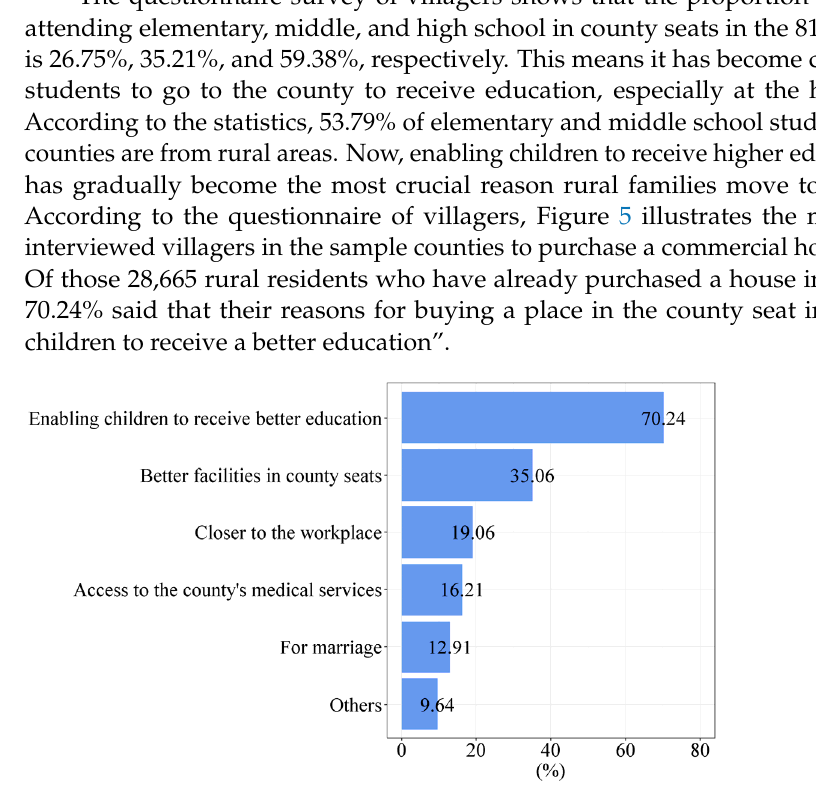
Figure 6. Rural residents’ choice of location for medical and health care (Source: by the authors). Therefore, with the increasing demand of rural residents for education and medical service levels of county seats, increasing the allocation of education and medical service resources and improving their quality is essential to promote the construction of urbani- zation with the county seat as the carrier. However, the level of education and medical services in the county seat has not yet met the needs of rural residents, and there are still apparent shortcomings. In terms of education services, according to statistics, the percentage of candidates admitted to Project 985 and Project 211 universities in the 81 sample counties in 2020 is only 3.84%, which is lower than the average level of the prefecture-level cities (7.43%) to which these counties belong. According to the questionnaire of villagers, Figure 7 shows the satisfaction rate of rural residents with the quality of education and boarding condi- tions of schools in county seats and prefecture-level cities (the proportion of respondents who chose “satisfied” and “relatively satisfied” to the total number of people). There are 26,049 children of the villagers interviewed enrolled in high schools in county seats. Among the respondents, 61.49% and 55.07% of them are “satisfied” or “relatively satis- fied” with the quality of education and boarding conditions of middle schools in the county seat, and 60.79% and 54.31% of respondents are “satisfied” or “relatively satisfied” with the quality of education and boarding conditions of high schools in the county seat, both of which are lower than the satisfaction for schools in the prefecture-level city. In general, education resources in county seats are relatively tight, and there is still a certain threshold for rural students to attend high school in the county seat. In addition, there is a large gap between the quality of education services in the county seat and the city.